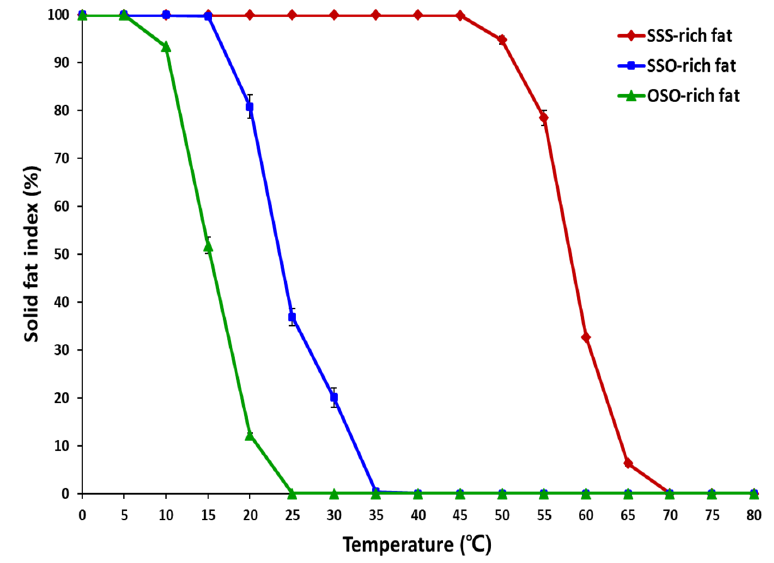
Figure 3. Solid fat index (SFI) of SSS-rich fat, SSO-rich fat, and OSO-rich fat.